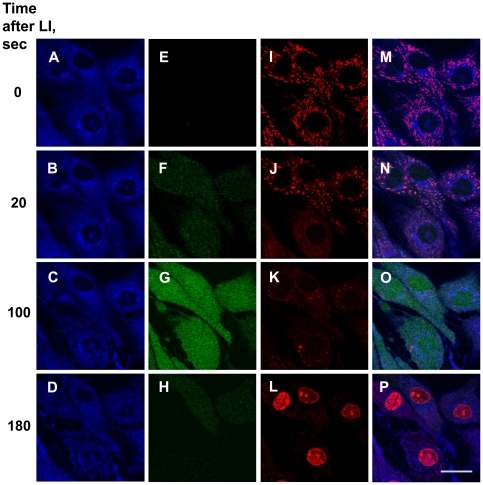
Time course of death-associated events after LI of cells loaded with compound 5.The C6 rat glioma cells were incubated with 1 µM of 5 for 15 min. at 37°C, 5%CO2. A–D: fluorescence of 5. E–H: ROS generation detected with DCFH-DA (4 µM, 5 min.). I–K: changes of mitochondrial morphology and a decrease of ΔΨm detectable with MitoTracker Red CM-H2XRos (0.5 µM, 5 min.). L, staining with PI (15 µM). Fluorescence of MitoTracker Red CM-H2XRos and PI was detected in the same channel. M: overlay of A, E and I. N: overlay of B, F and J. O: overlay of C, G and K. P: overlay of D, H and L. Shown are optical sections. Bar, 20 µM.